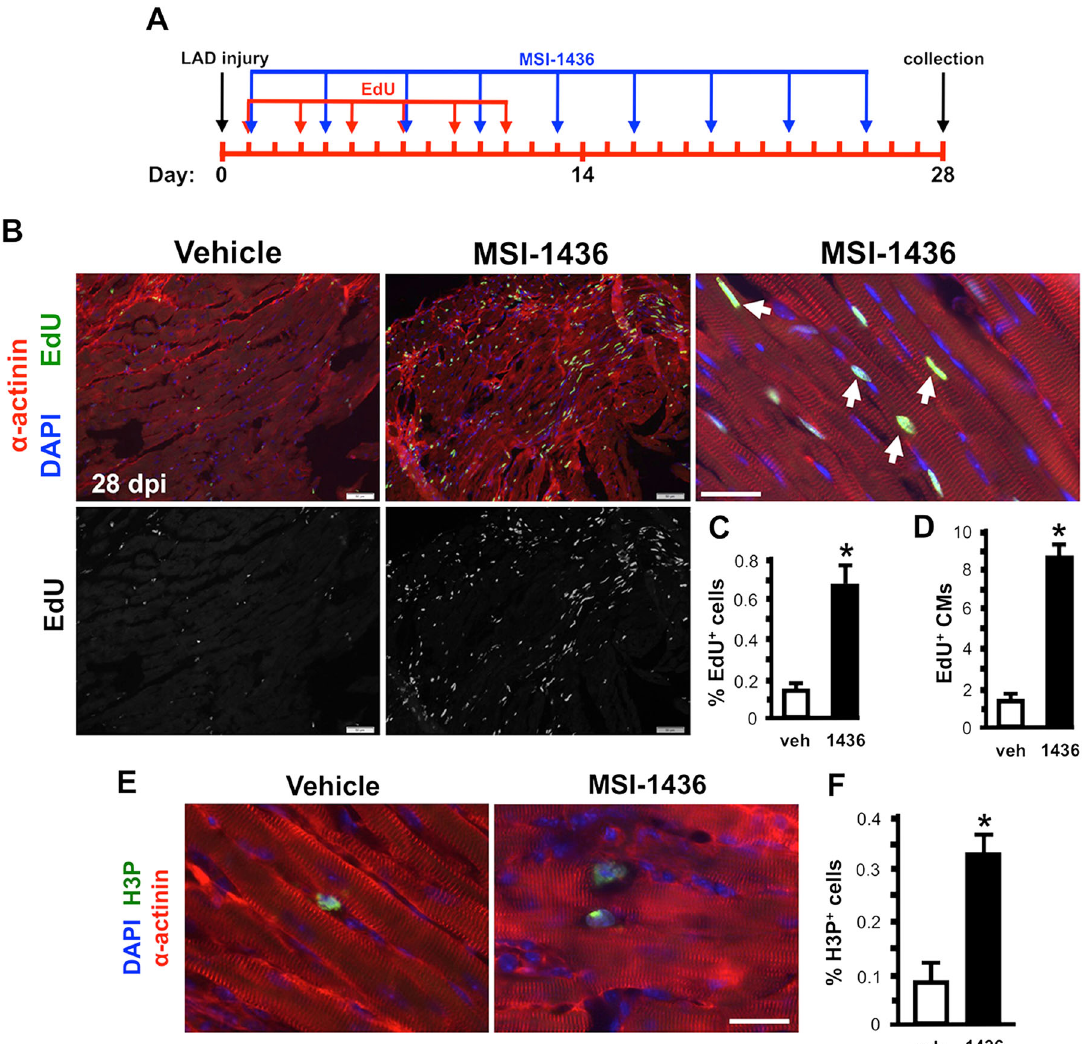
Fig. 5 MSI-1436 stimulates cardiomyocyte proliferation in adult mouse heart following ischemic injury. a Protocol for EdU labeling of mouse hearts. b Representative images showing EdU labeling of infract border zone in hearts isolated 28 dpi from vehicle-treated mice and mice administered 0.125 mg/kg MSI-1436. Arrowheads indicate EdU+ cardiomyocytes. Scale bar in left and middle panels corresponds to 50 microns. Scale bar in right panel is 25 microns. c , d Quanti fi cation of EdU labeled cells and EdU+ cardiomyocytes (CMs). Values are means ± S. E. ( n = 8). * P < 0.05 compared to vehicle-treated mice. e Representative image of cardiomyocytes labeled with antibodies to phosphorylated histone 3 (H3P). f Values are means ± S.E. ( n = 5-7). * P < 0.05 compared to vehicle-treated mice. Scale bar in (e) is 25